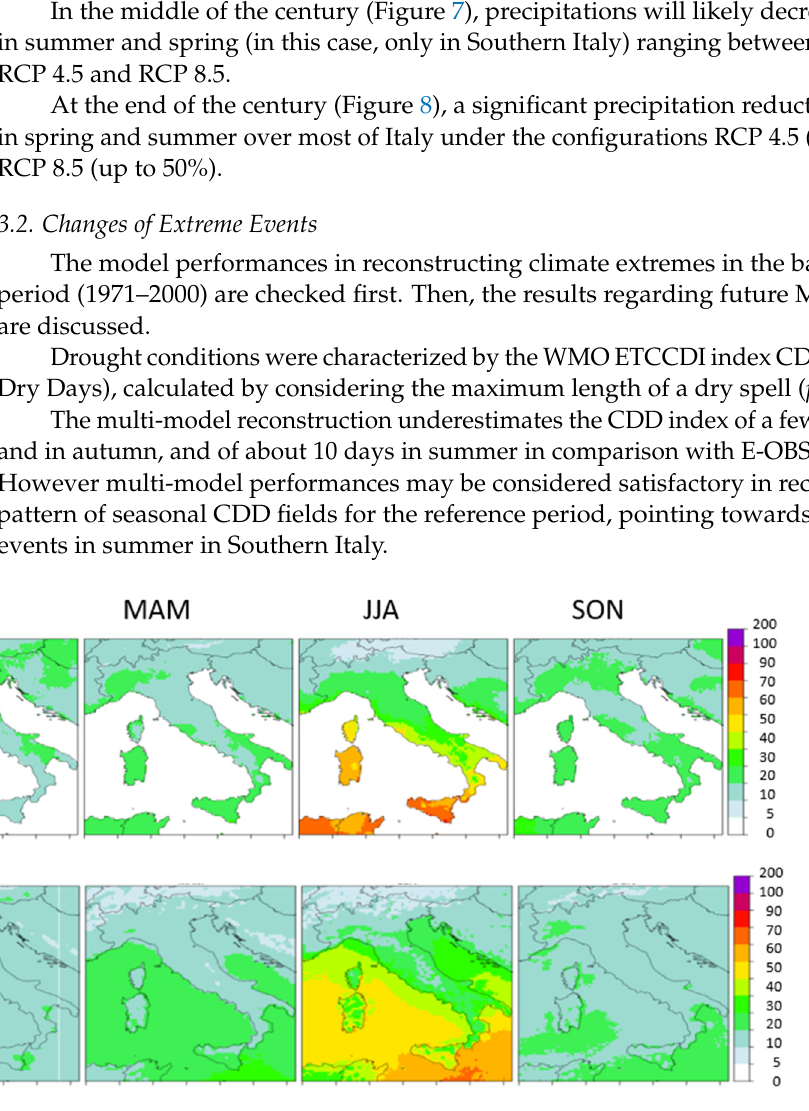
Figure 9. CDD reference scenarios 1971–2000 calculated at seasonal scale, expressed as maximum length (number of days) of dry spell ( pr < 1 mm), estimated using E-OBS (top) and multi-model ensemble (bottom).